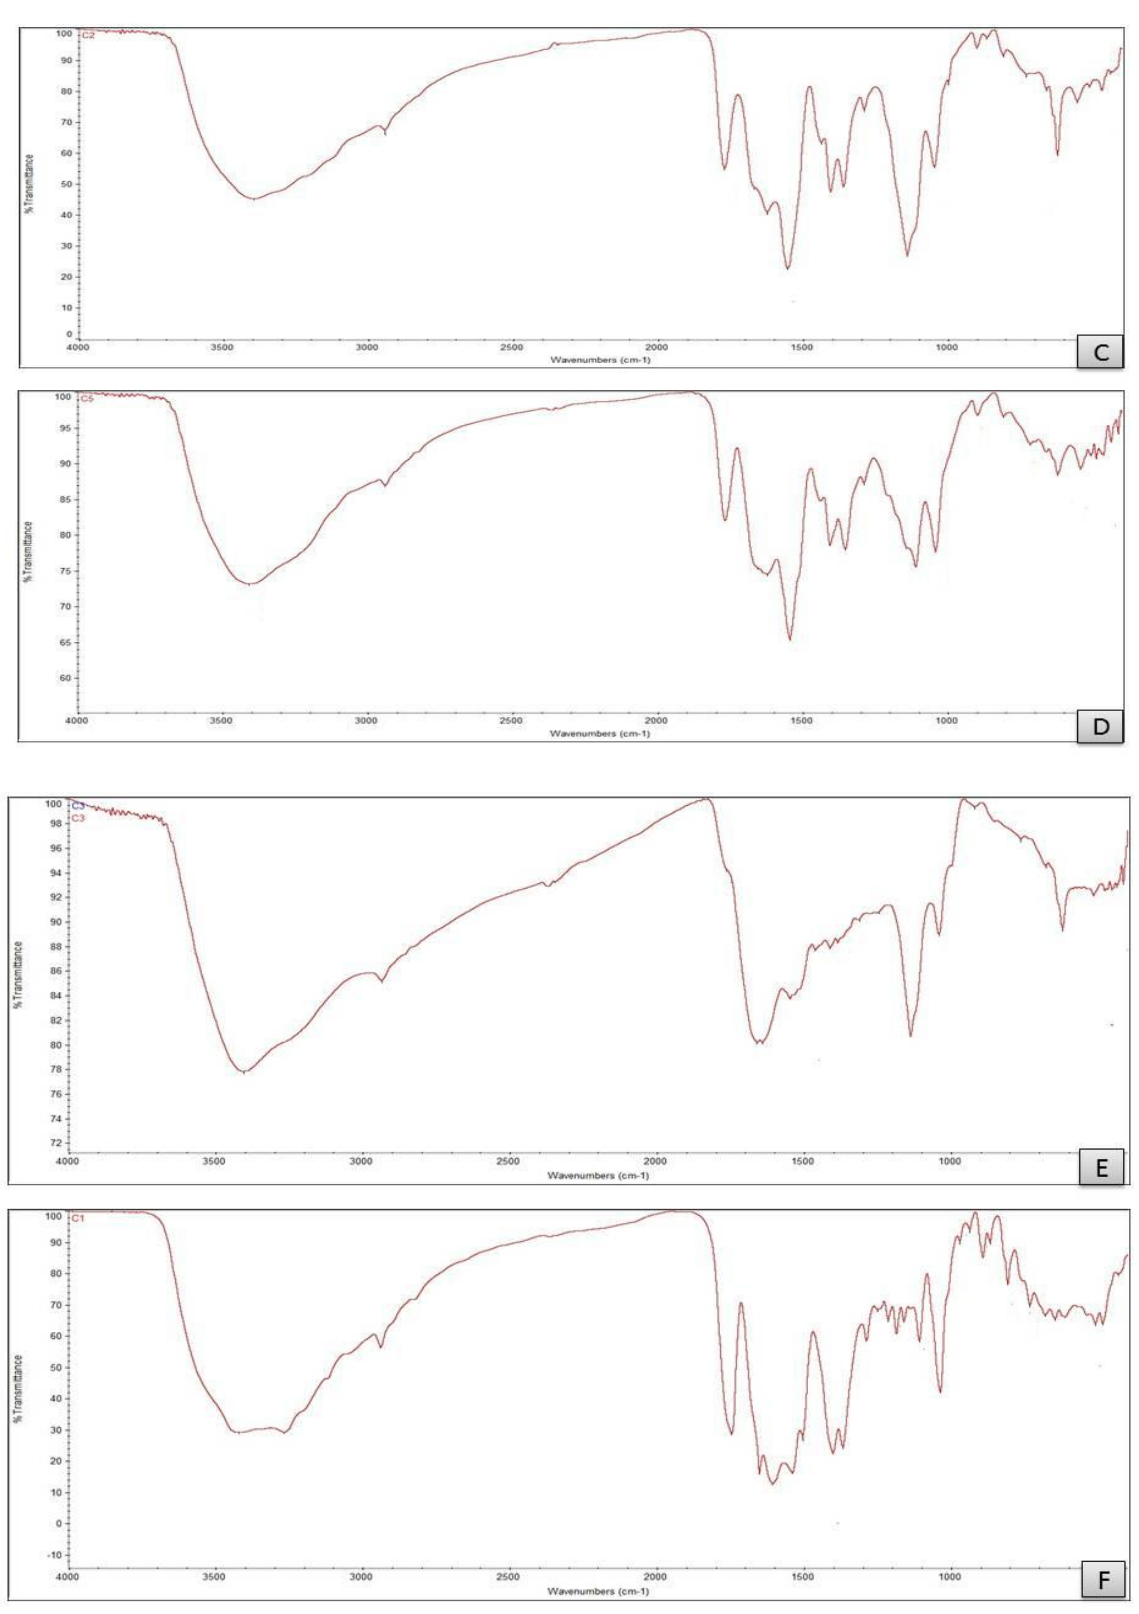
Figure 2. FT-IR of ( A ) CFX, ( B ) CFX/Mg, ( C ) CFX/Cu, ( D ) CFX/Fe, ( E ) CFX/Se and ( F ) CFX/Zn.